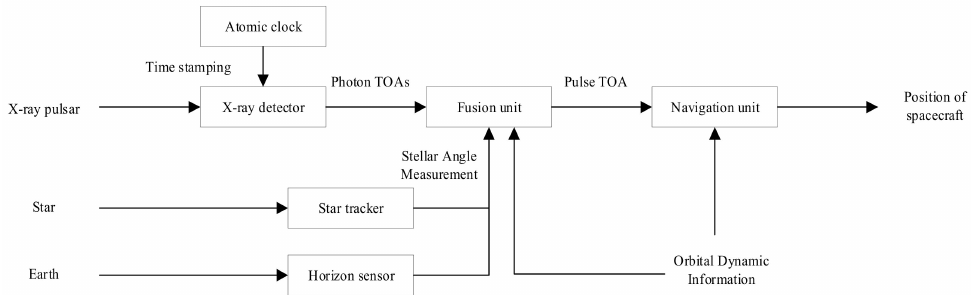
Figure 1. Composition of the proposed deeply integrated navigation system using the X-ray pulsar and stellar angle.